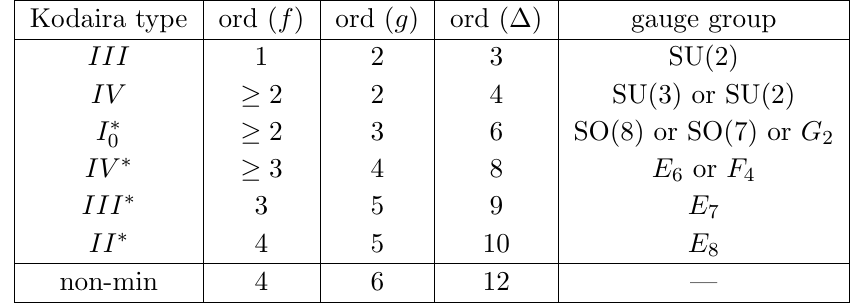
| Table 1 . Table of non-Higgsable non-Abelian gauge groups and their Kodaira singular (cid:12)ber type. For the Kodaira (cid:12)bers IV , I (cid:3) and IV (cid:3) , the gauge group is not uniquely determined by the orders 0 of vanishing of f; g . One needs additional monodromy information in the Weierstrass polynomials to (cid:12)x the precise gauge group. Note that actually only the gauge algebra is determined by